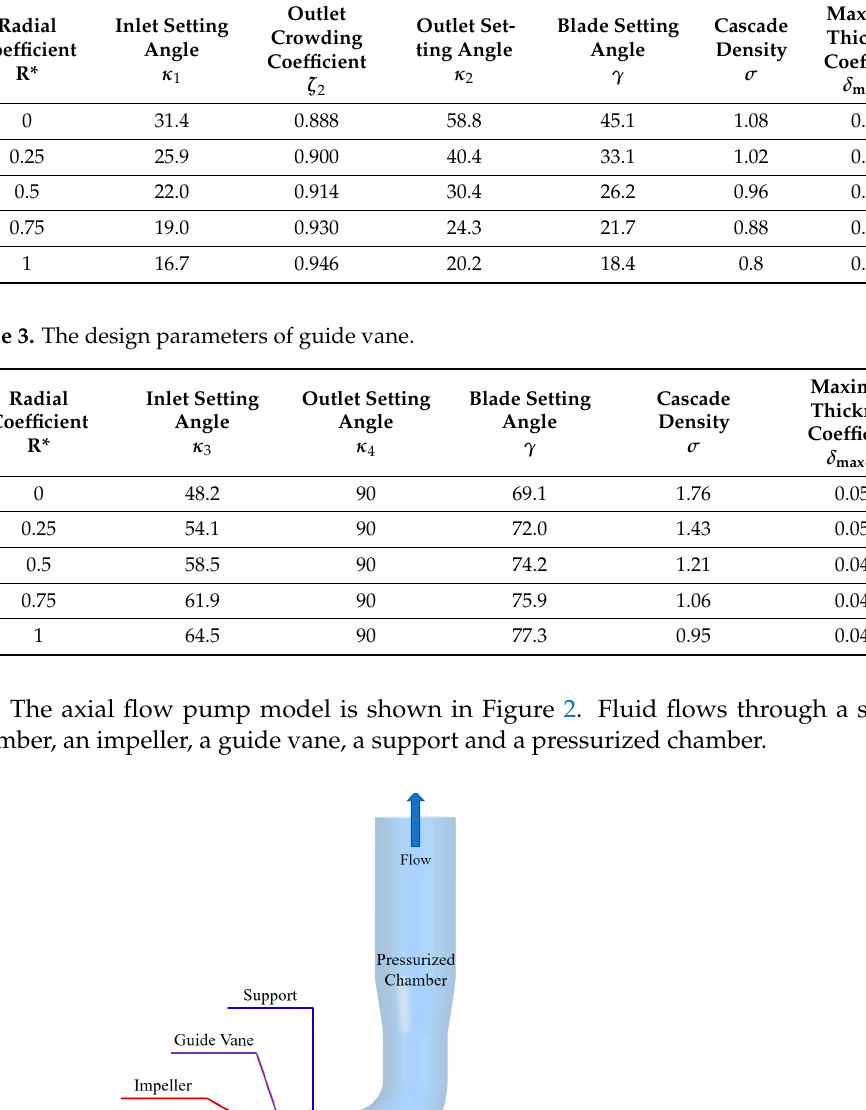
Table 2. The design parameters of impeller.